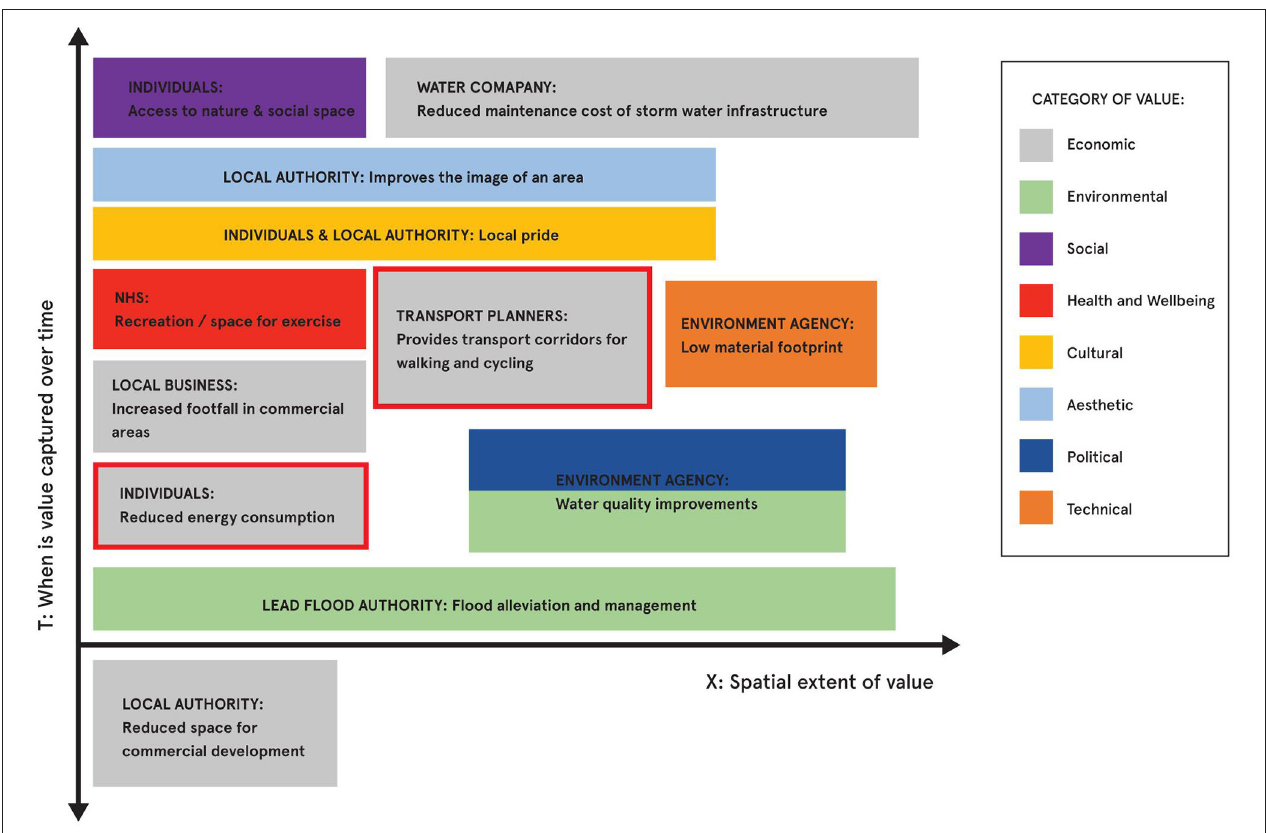
FIGURE 4 | Value map for the installation of urban green infrastructure in the Helix site.